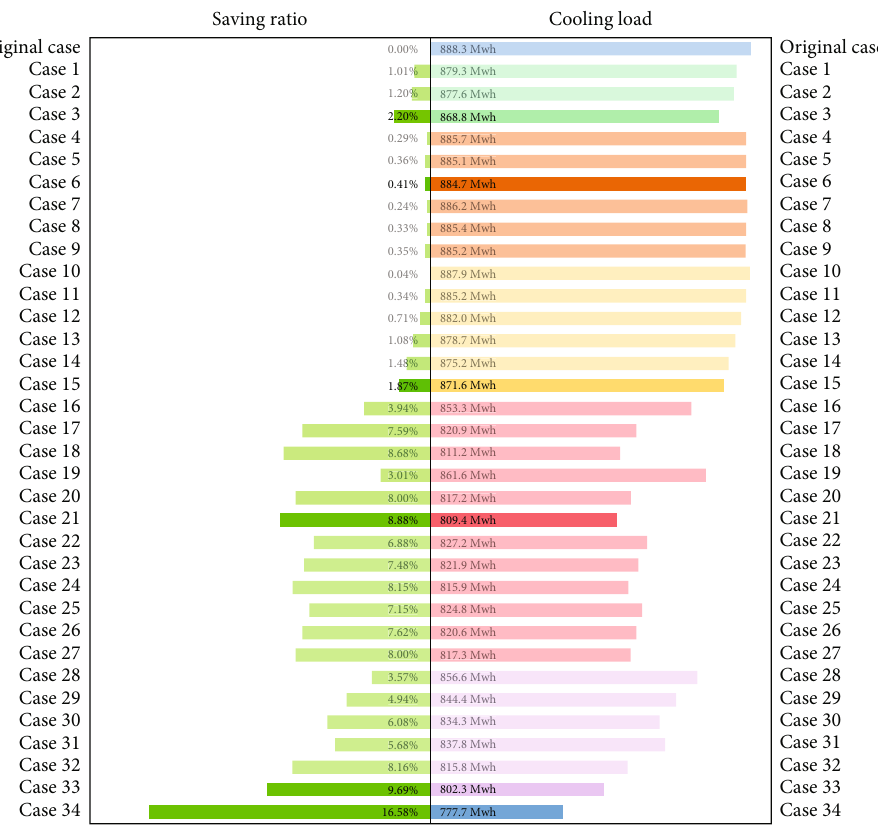
Figure 19: Cooling load and saving